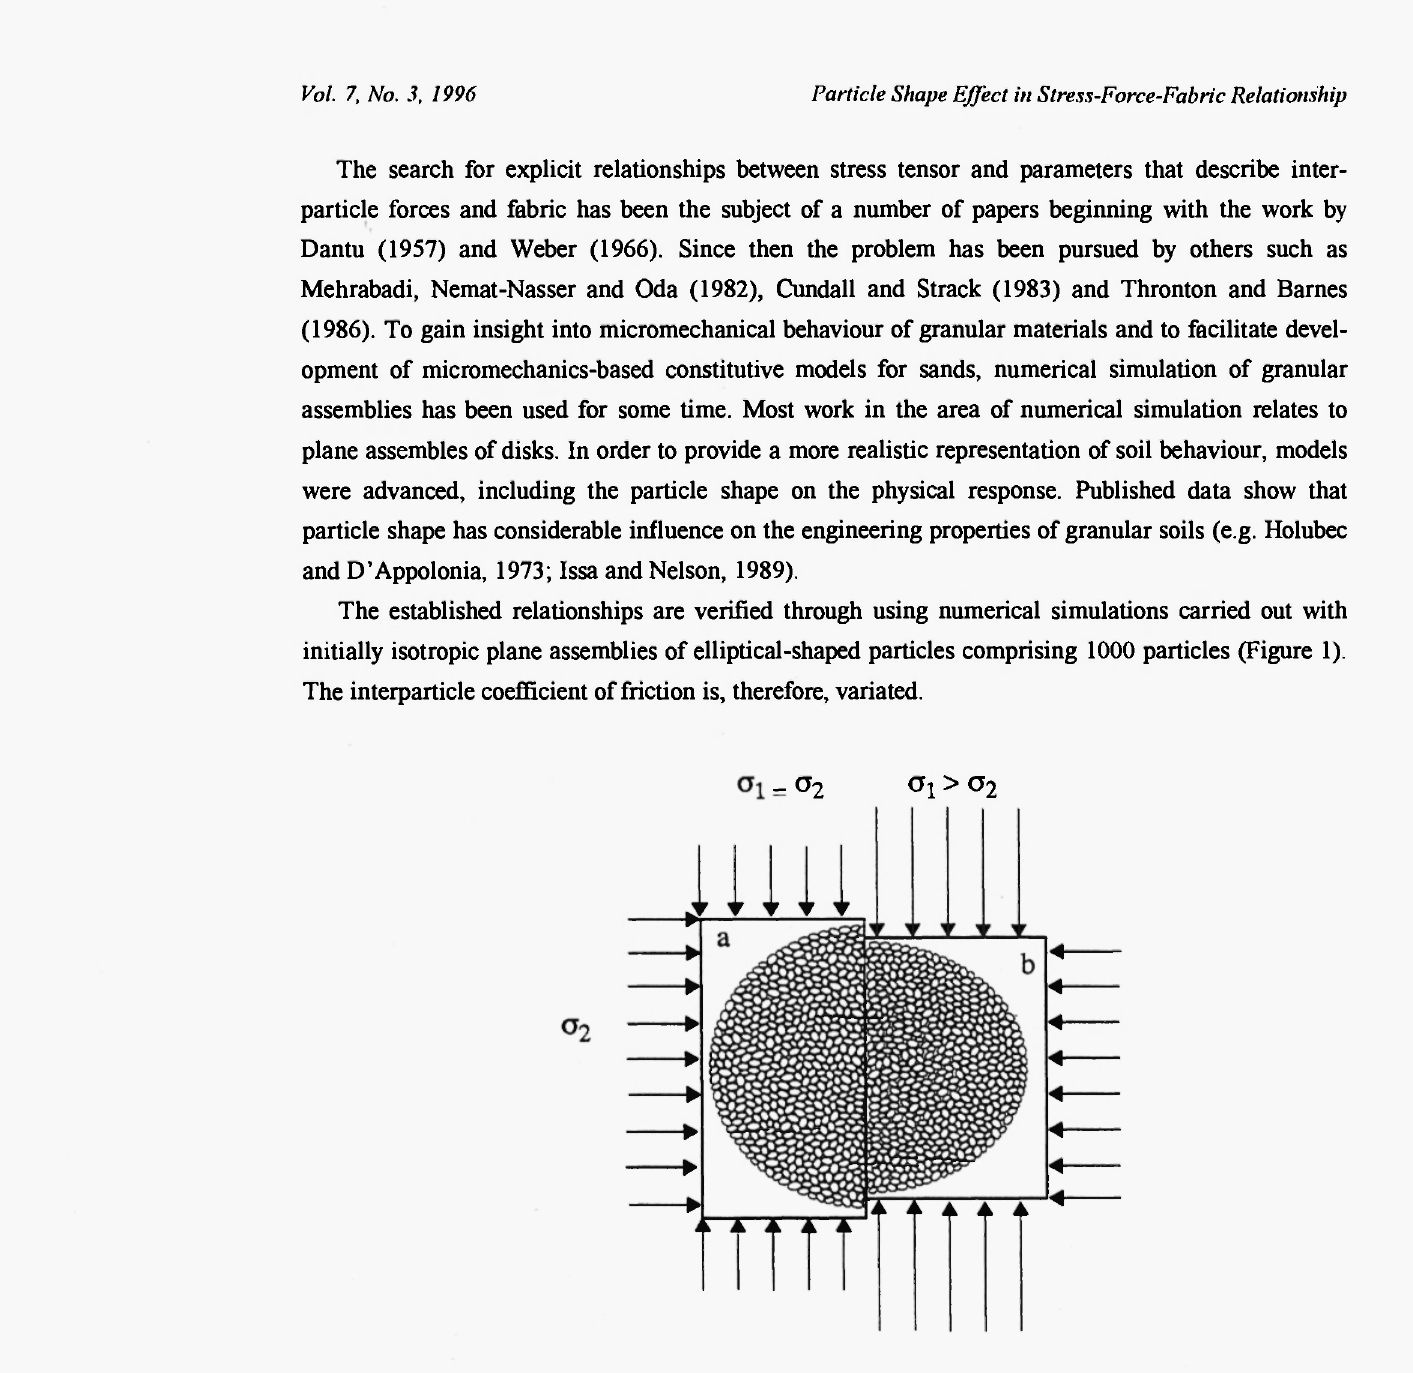
Fig. 1: Assembly of elliptical particles: (a) before biaxial compression, (b) after biaxial compression